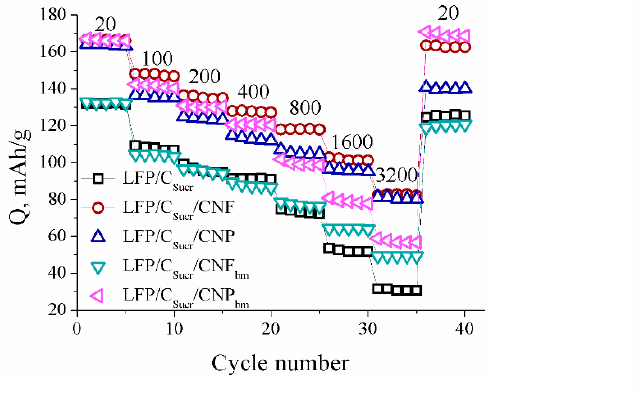
Table 2. The effect of carbon additives on the electrochemical performances of some LFP/C com- posites.